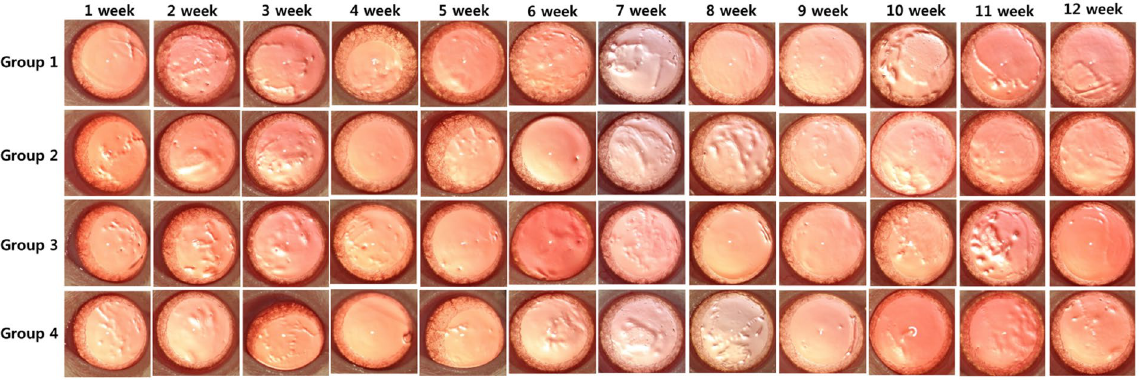
Figure 2. In vivo corneal effects of the SiNP applications. Digital photographs were obtained every week for 12 weeks. Corneal transparency and limbal vessels were normal in all the treated groups (Group 2, oral intake 100 mg/kg; Group 3, oral intake 1000 mg/kg; Group 4, topical application 10 mg/ml) as compared to those of the controls (Group